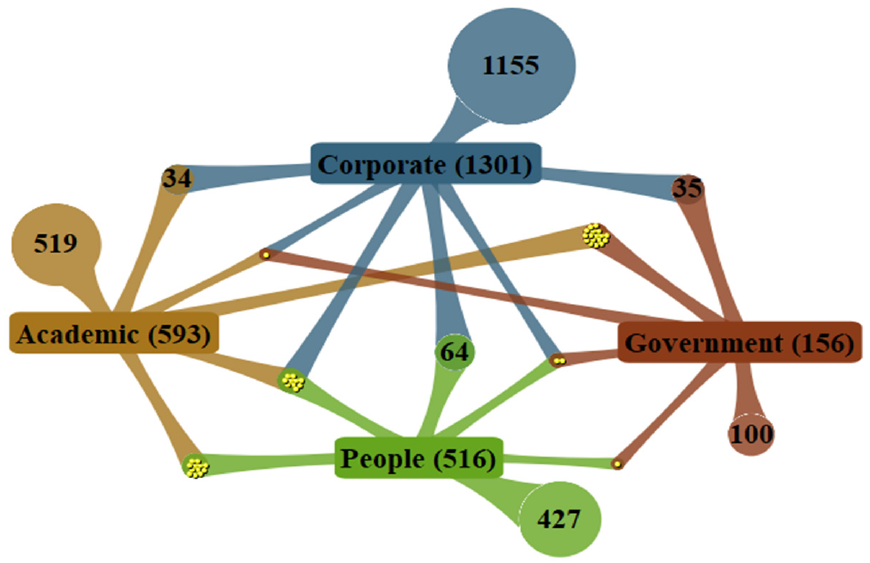
Figure 8. Collaboration mapping of groups of assignees.